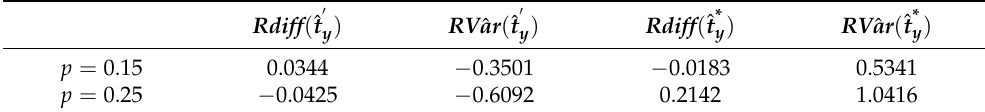
Table 3. Relative measures of accuracy for the estimators of totals in the case of enterprise joining.